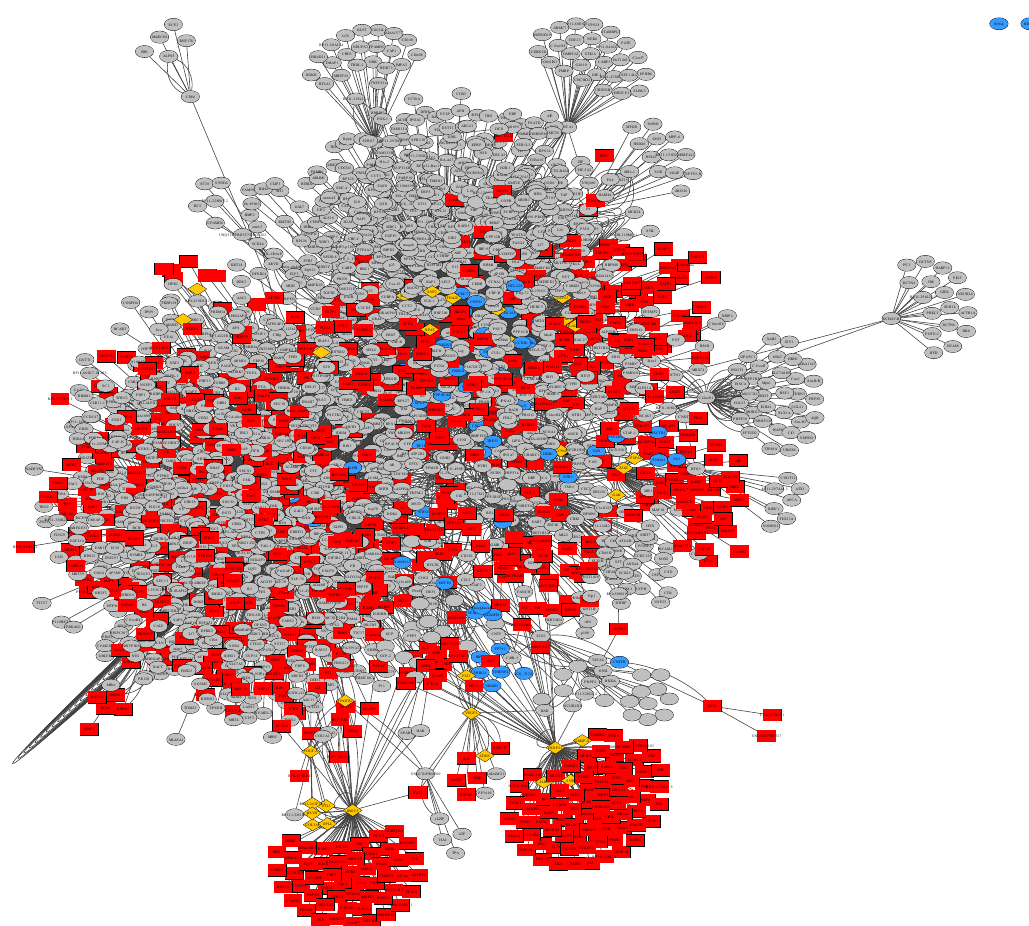
Figure 4. Merged union network of general glioma, glioblastoma multiforme and low-grade astrocytoma samples, constructed from BioGrid in Cytoscape, rendered with Prefuse Force Directed Layout, clustered by ClusterOne (grey: outlier, yellow: overlap, red: cluster, blue: unassigned/default).